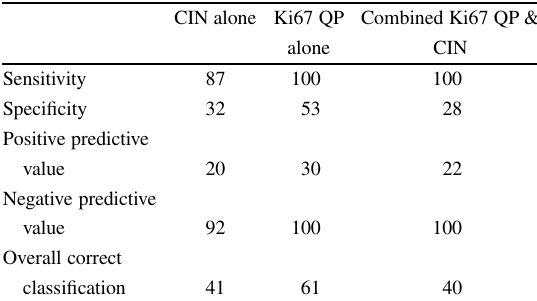
Quantitative measurement of Ki67 alone is superior to Ki67 com- bined with CIN grade